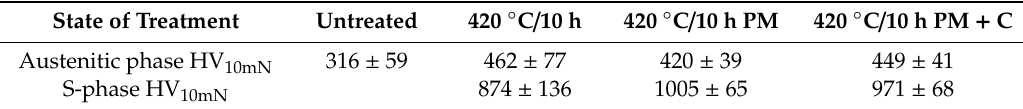
Table 4. Hardness of the AISI 316L HVOF coatings before and after gas nitriding.